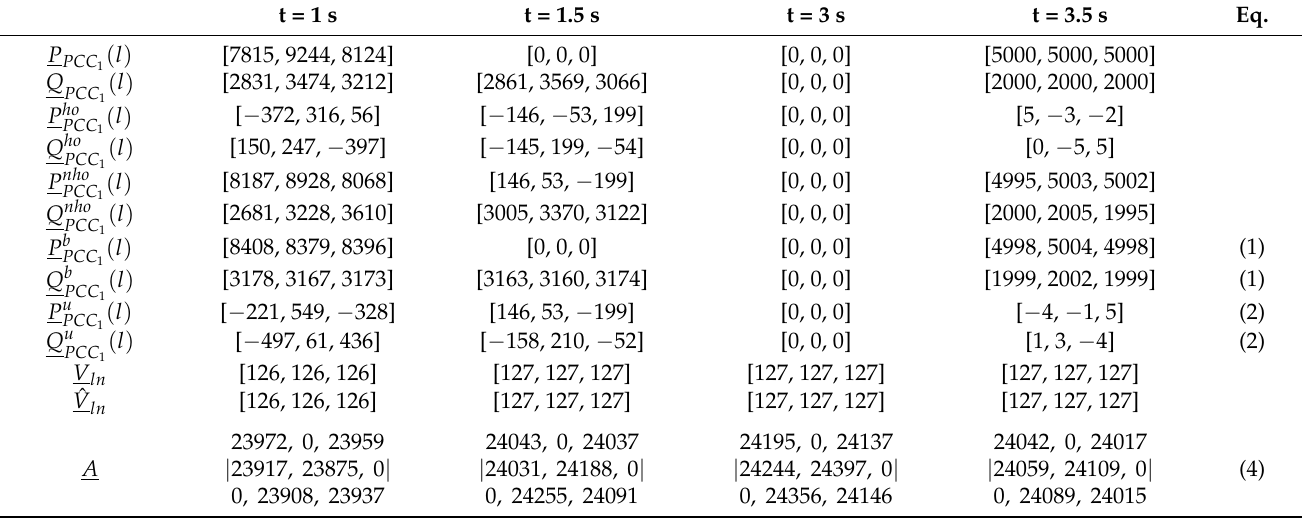
Figure 5. Reactive power in PCC 1 and scalar coefficients ( α Qm ) for MPBC and PBC. Table 4. MPBC quantities at four instants of the µ G simulation in this case